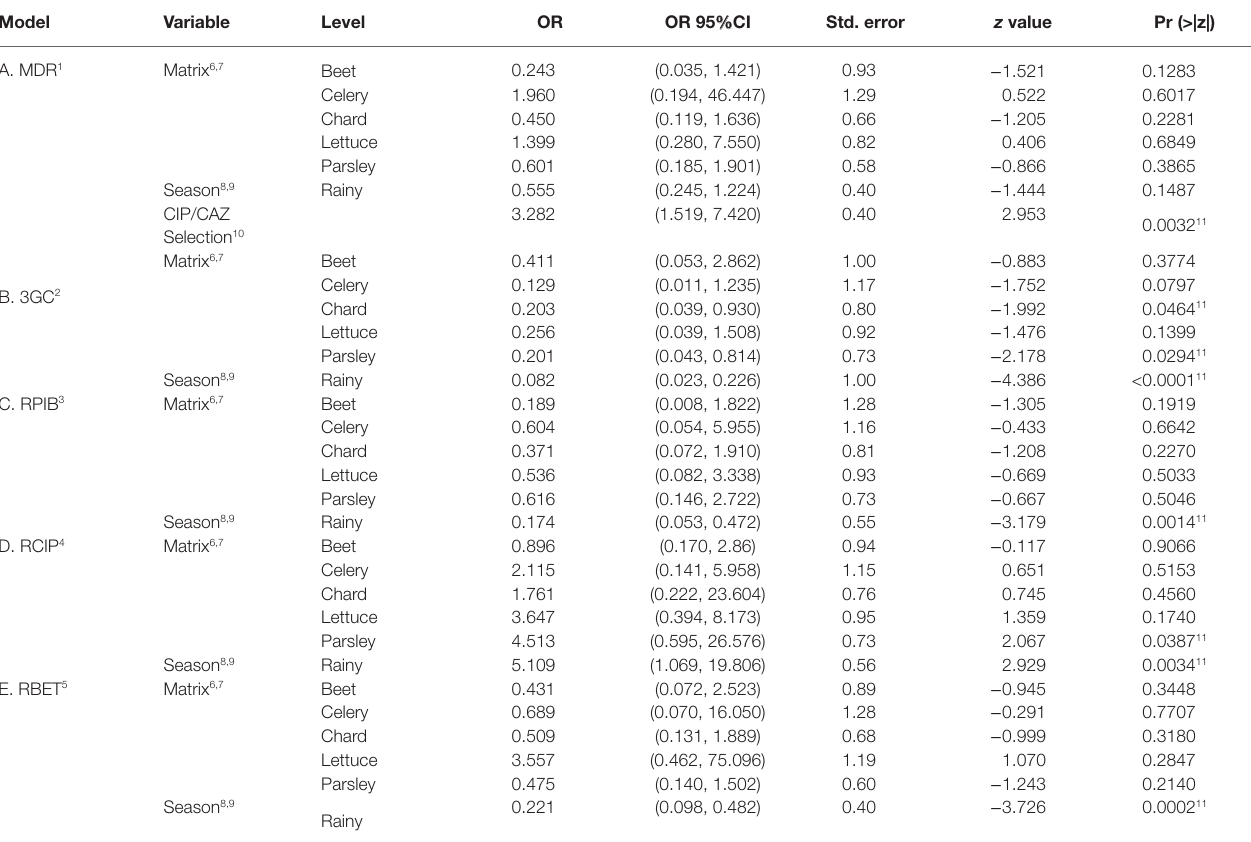
TABLE 5 | Multivariate generalized linear model testing the influence of Matrix and season on the likelihood of each Enterobacterales isolate’s resistance based on Kirby-Bauer and CLSI standards: (A) Multidrug resistance (MDR) 1 and resistance to at least one antibiotic of the following families: (B) third-generation cephalosporin (3GC) 2 ; (C) Penicillin with β -lactamase inhibitor (RPIB) 3 ; (D) Ciprofloxacin (RCIP) 4 ; and (E) β -lactam (RBET) 5